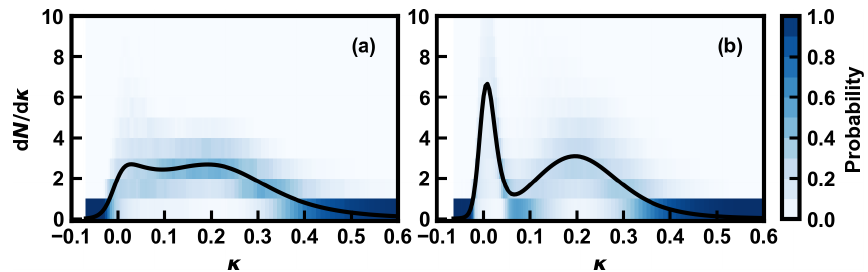
Figure 1. Typical κ -PDF for 100nm aerosols in winter (a) and summer (b) measured by the H-TDMA over Chengdu. The shaded area is the frequency distribution of κ -PDF, and the solid lines show the campaign average of κ